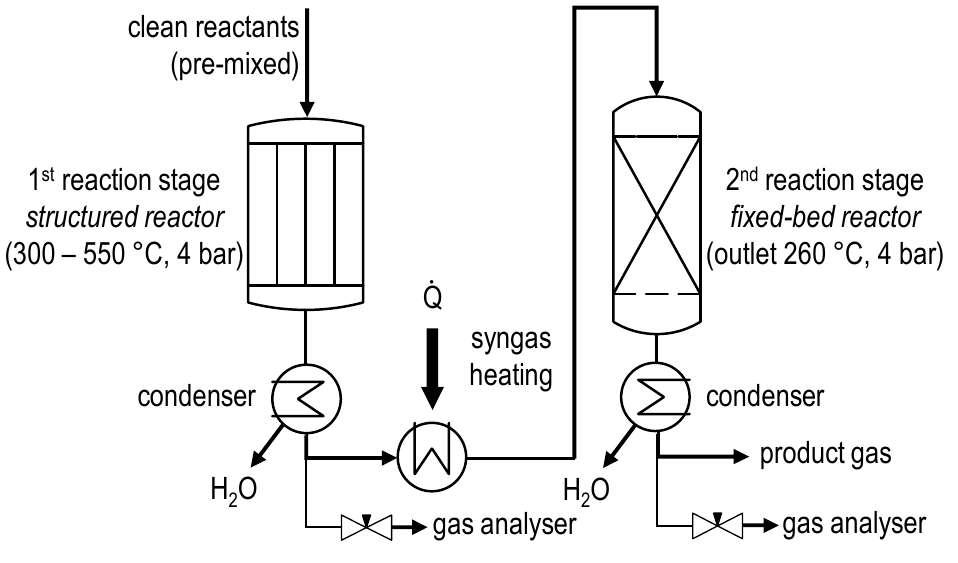
Figure 1. Simplified flowchart of FAU_CH4_TR [48].